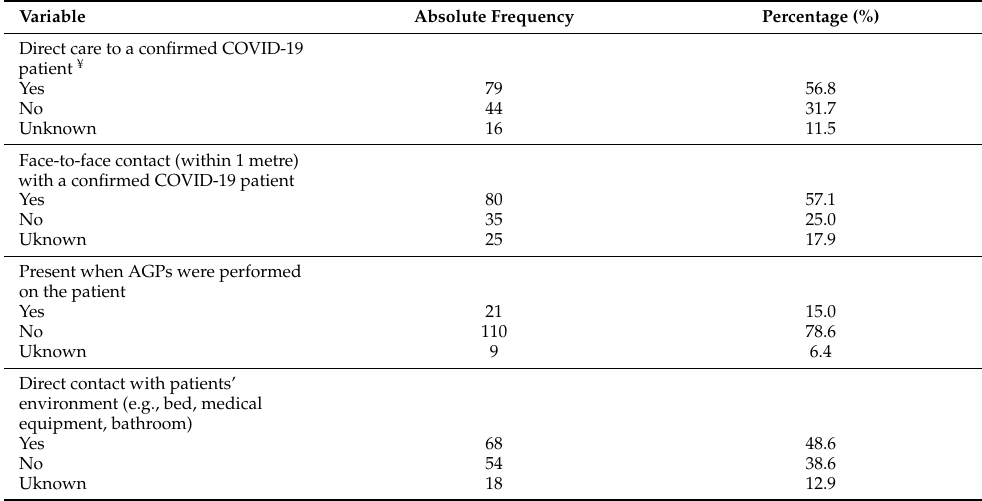
Table 2. Biomedical scientists’ activities performed on COVID-19 patients in healthcare